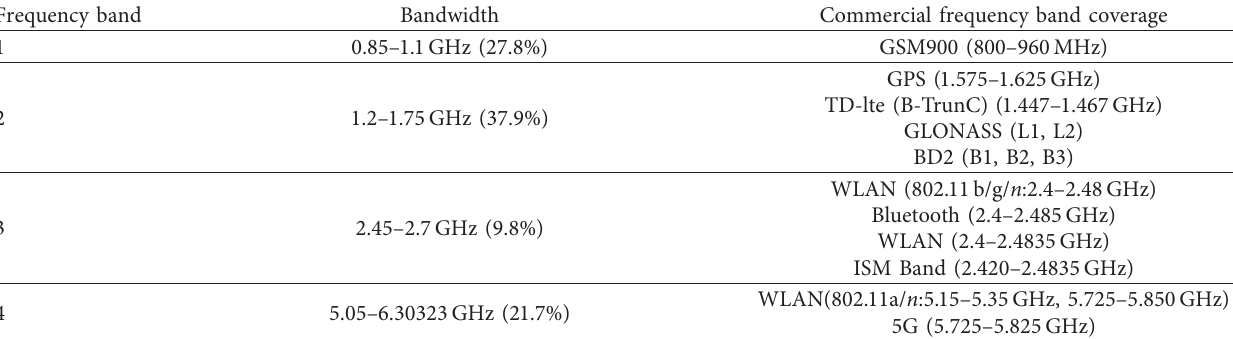
Table 3: Antenna measured frequency band